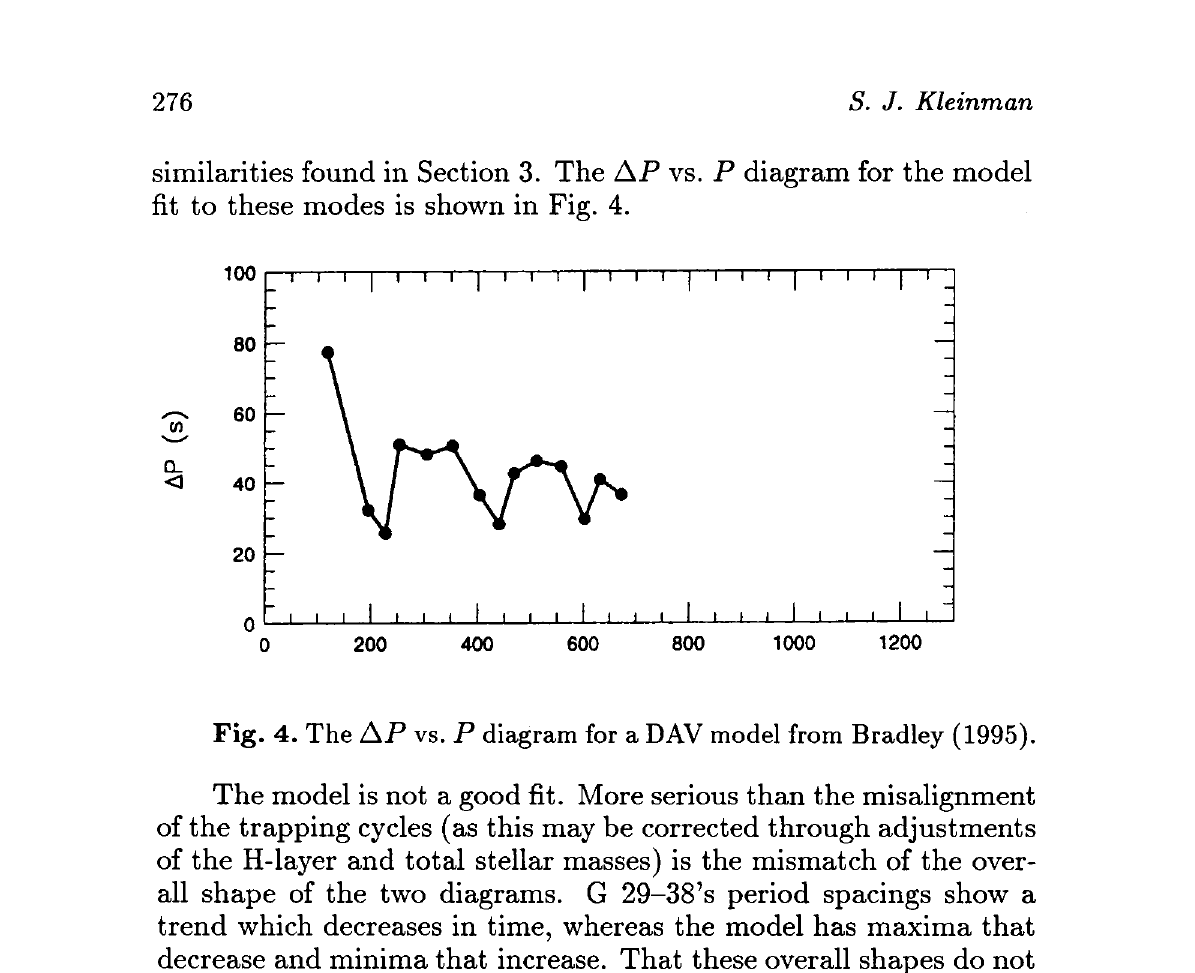
Fig. 4. The A P vs. P diagram for a DAV model from Bradley